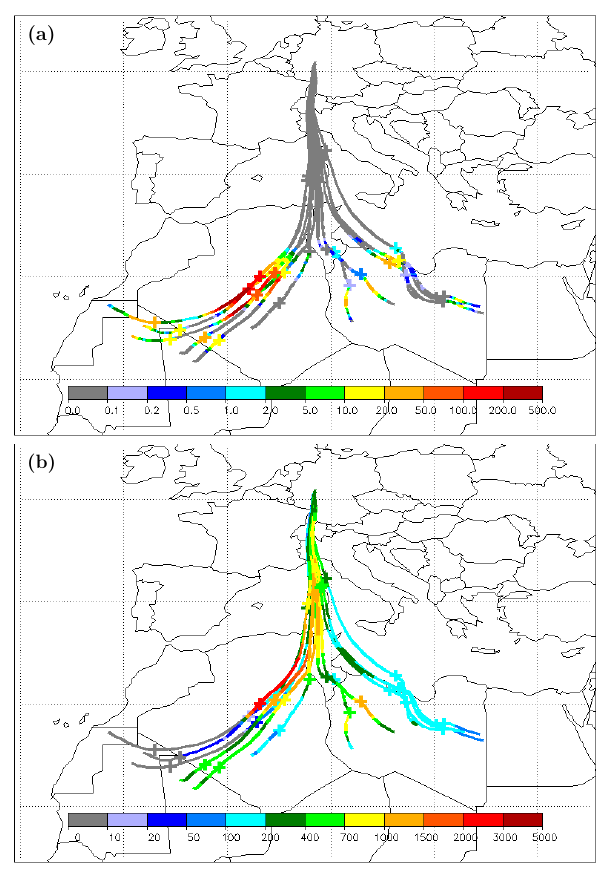
Fig. 10. 90-h backward trajectories initialised on 28 May 2008 18:00UTC starting in intervals of 30hPa from the surface to 350hPa at Mt. Kleiner Feldberg. Only trajectories with northward displacement larger than 22 ◦ latitude are displayed. Coloured vari- ables along the trajectories are (a) the dust emission (µgm − 2 s − 1 ) and (b) the dust concentration (µgm − 3 ). A “+” is drawn every